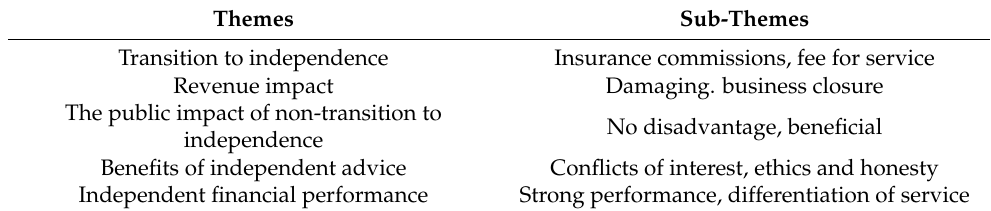
Table 1. Themes and sub-themes.